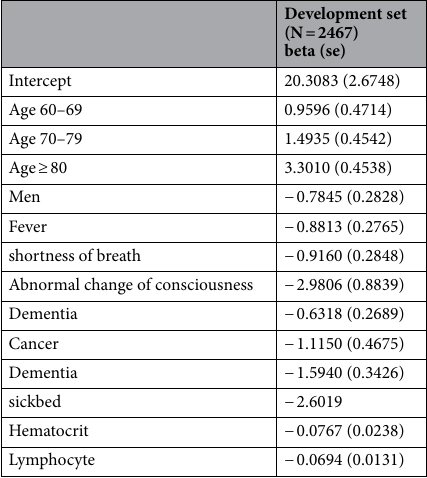
Table 3. Mortality prediction equation: logistic model (equation using development